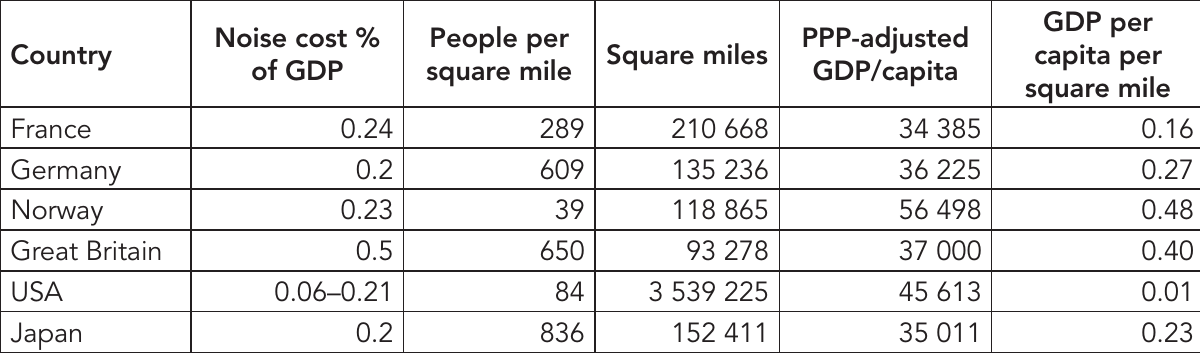
Table 6: Data used for estimating noise cost as percentage of GDP